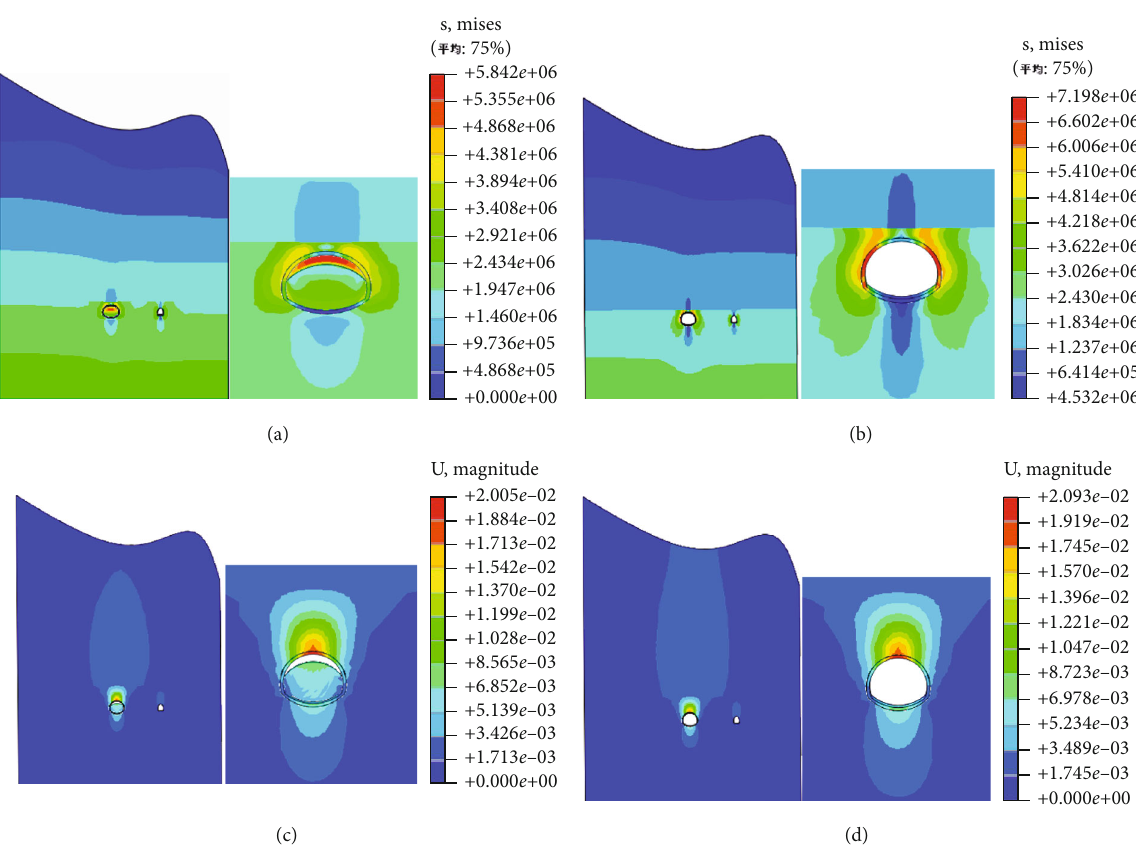
Figure 7: Stress diagram and displacement diagram of the upper and lower step method: (a) step 13: excavation stress diagram, (b) step 19: excavation stress diagram, (c) step 13: excavation displacement drawing and local enlarged drawing, and (d) step 19: excavation displacement diagram and partial enlarged